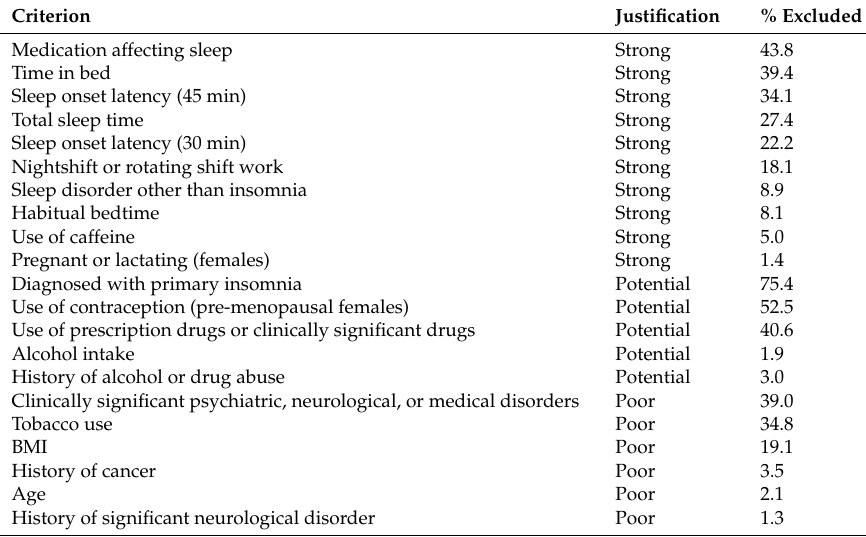
Table 2. Eligibility rates of survey participants.